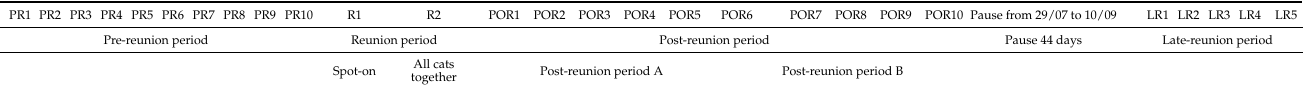
Table 1. All the study periods are summarised. Ten days of data collection were conducted for both the pre-reunion period and the post-reunion period (PR1-PR10; POR1-POR10, respectively). The post-reunion period was divided into two periods: post-reunion period A (POR1-POR5) and post-reunion period B (POR6-POR10). Five days of data collection were run for the late reunion (LR1-LR5). R1 indicates the beginning of the reunion process, in which we provided semiochemicals to all individuals and released RF and the mother; R2 indicates the second day, when all five wildcats were together again. PR1 PR2 PR3 PR4 PR5 PR6 PR7 PR8 PR9 PR10 Spot-on Allcats together